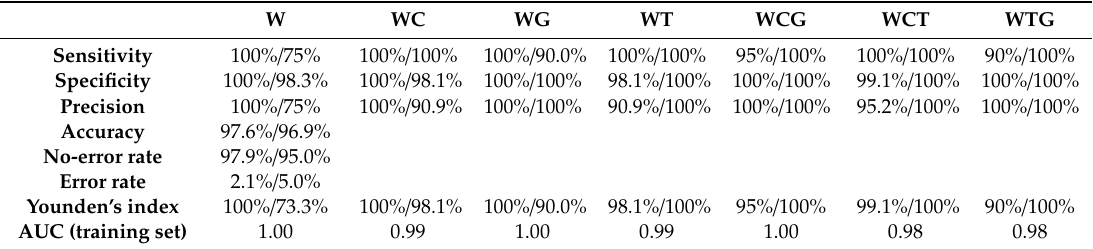
Table 2. The classification performance parameters of the SIMCA model with 500–1100 cm − 1 spectral regions. The first value is the training group, and the latter value represents the test